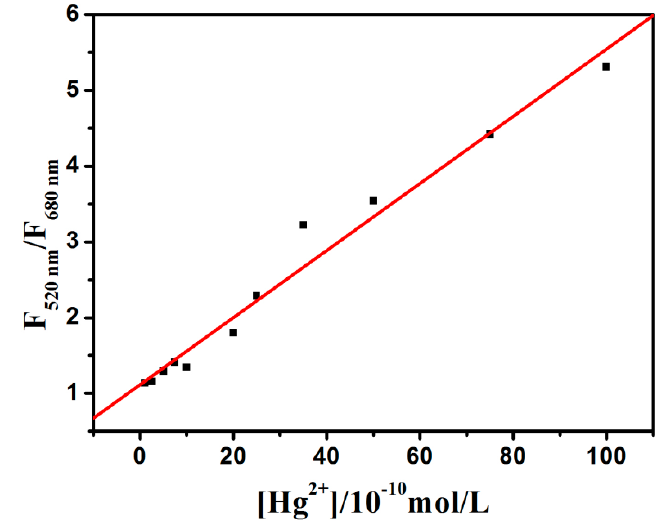
Figure 7. The F 520nm /F 680nm intensity of RFN versus the concentration of Hg 2+ .